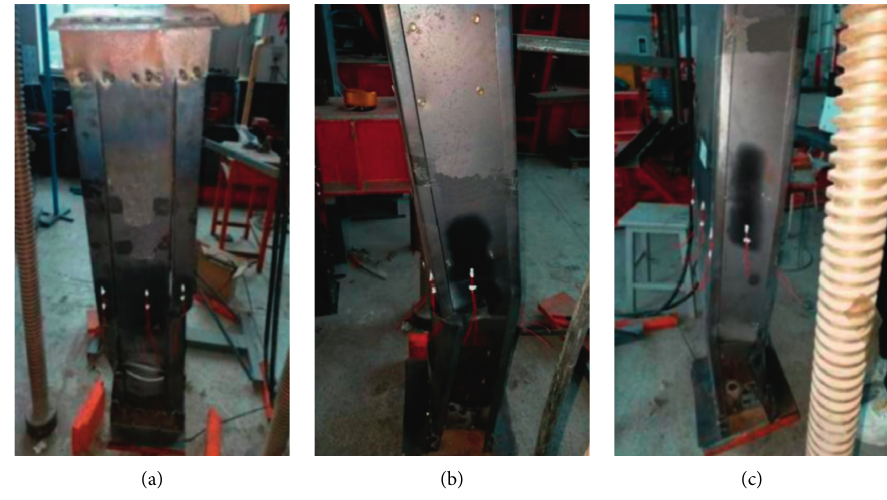
Figure 15: 4C-2 failure mode: (a) south, (b) east, and (c) west.